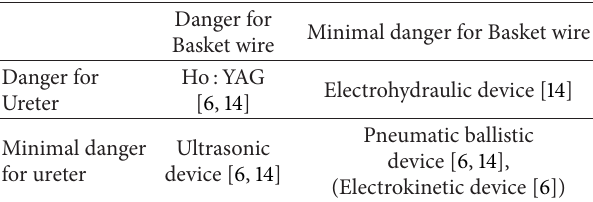
Table 1: Potential Dangers of Lithotriptors: Danger for the ureter tested by Piergovanni et al. [14] (not testing the Electrokinetic device). Danger for the basket wire tested by Cordes et al. [6] (not testing the electrohydraulic